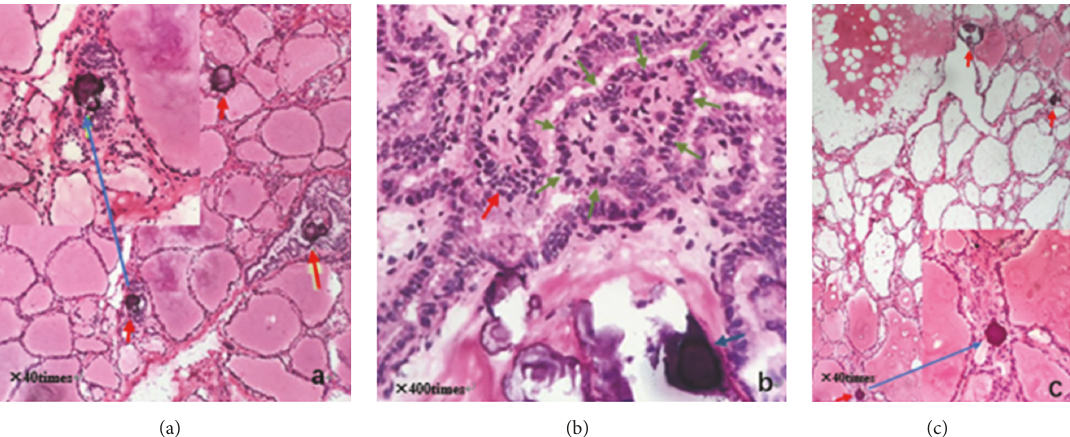
Figure 2: (a) Intraoperative frozen pathology of right thyroid lobe: red arrow for psammoma body. (b) Intraoperative frozen pathology of thyroid isthmus: red arrow for heterocyst; blue arrow for psammoma body; green arrow for papillary structure. (c) Intraoperative frozen pathology of left thyroid lobe: red arrow for psammoma body.